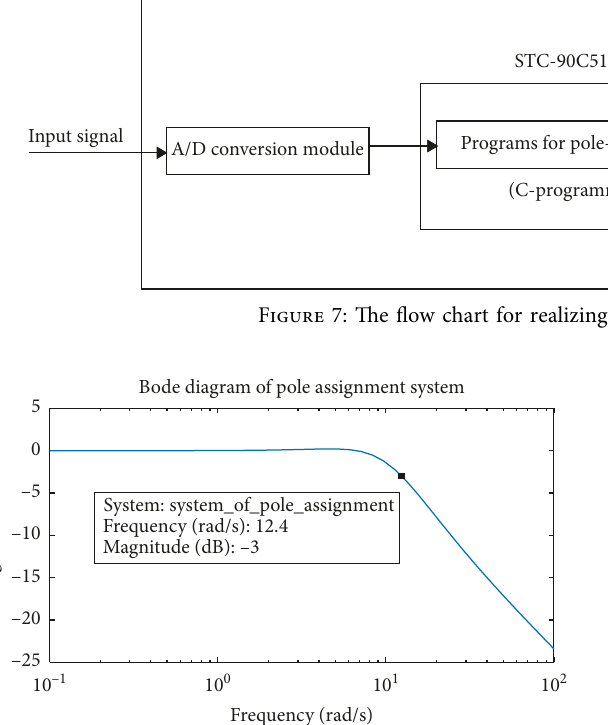
Figure 8: The bode diagram of the system after the pole